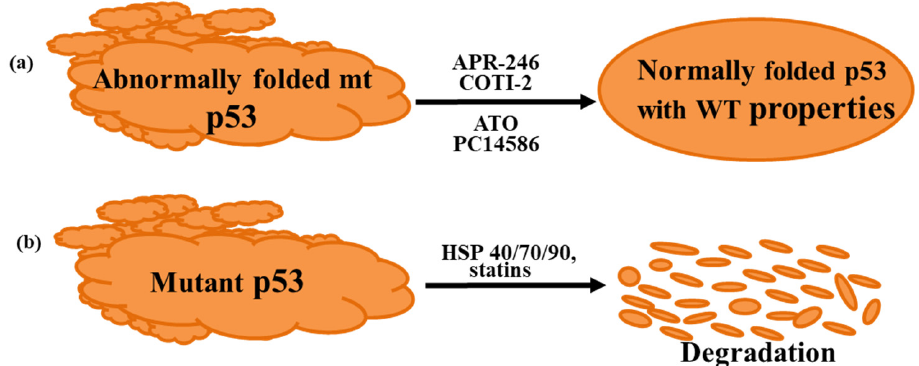
Figure 1. Strategies used to target mutant p53. ( a ) Reactivation of mutant p53 to a form with wild-type properties, ( b ) degradation and elimination of mutant p53. ATO, arsenic trioxide; HSP, heat shock protein.